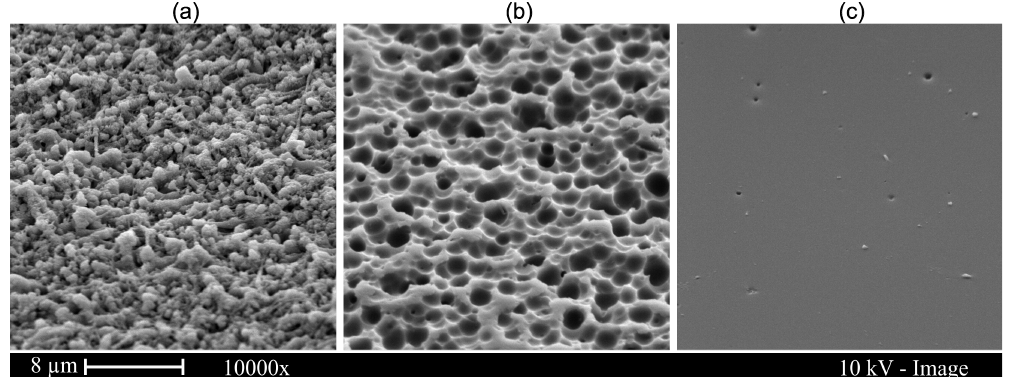
Figure 3. SEM images of laser-structured microchannel surfaces after certain steps of the fabrication. The first ( a ) image shows the surface of the glass right after the laser ablation. For the second image ( b ), the glass was dipped in a glass-etching solution for 90 s resulting in typical surface pits. For the third image ( c ), the etched glass was tempered at 760 °C for 1 h resulting in an almost perfectly smooth surface.